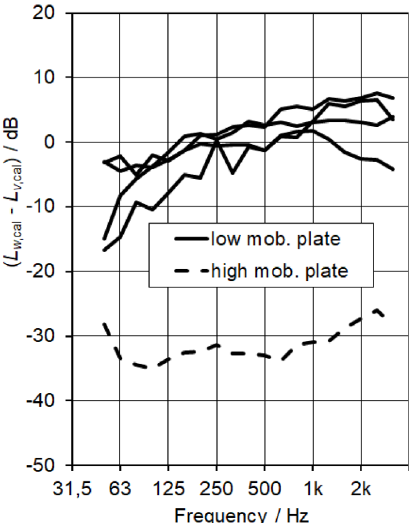
Figure 7. Difference between injected sound power level and mean velocity level on the non-isolated low mobility and the high mobility reception